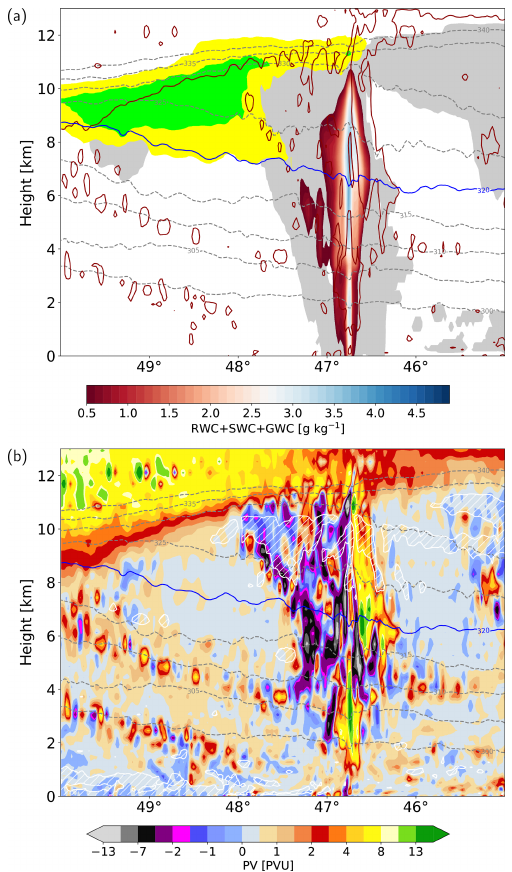
Figure 10. Vertical cross section through the PV dipole shown in Fig. 9c (black line) at 09:00UTC, 23 September 2016, for (a) the sum of rain, snow, and graupel water content (RWC + SWC + GWC, colors, in gkg − 1 ); cloudy region (grey shading, hydrometeor content > 1mgkg − 1 ); upper-level jet (yel- low and green shading at 55 and 60ms − 1 ); 2PVU contour (dark red line); (b) PV (colors, in PVU); and low static stability lay- ers (d θ/ d z ≤ 2Kkm − 1 , white contour and hatching). Isentropes (dashed contours, every 5K) and the 320K isentrope (blue line) are shown in both